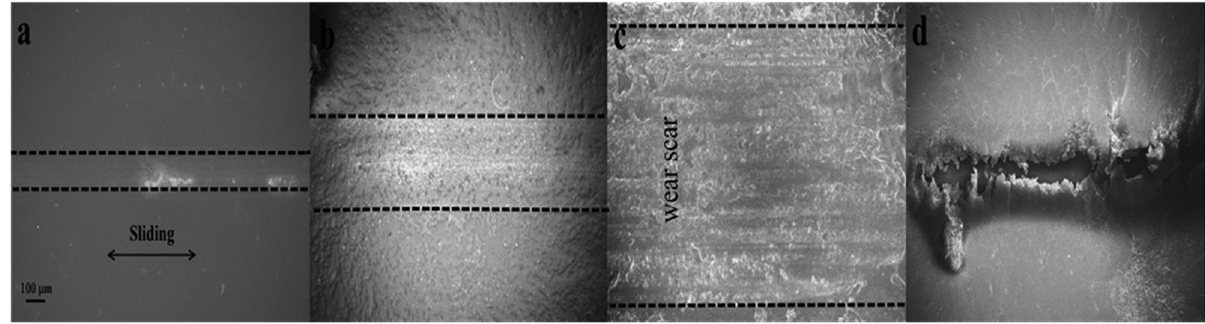
Figure 11: OCP wear surface images of AISI 316L coated with PU – PDMS polymers in Ringer ’ s solution: ( a ) PU, ( b ) PU75 – PDMS25, ( c ) PU50 – PDMS50, and ( d ) PU25 – PDMS75.